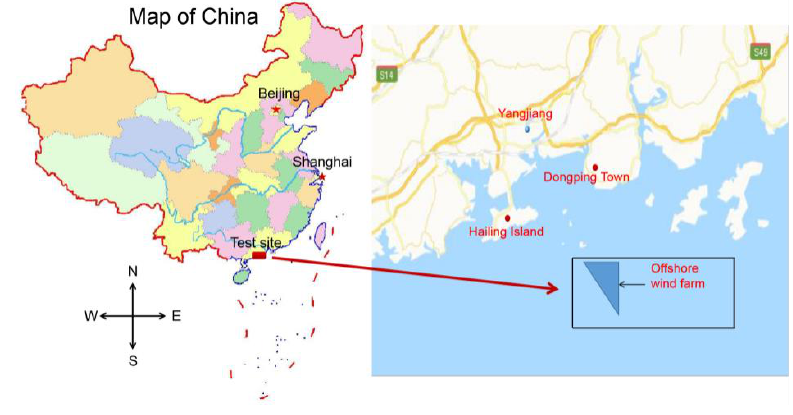
Table 2. Sea states of the reference sea areas in Guangdong Province, China. Figure 13. Location of the reference offshore site.